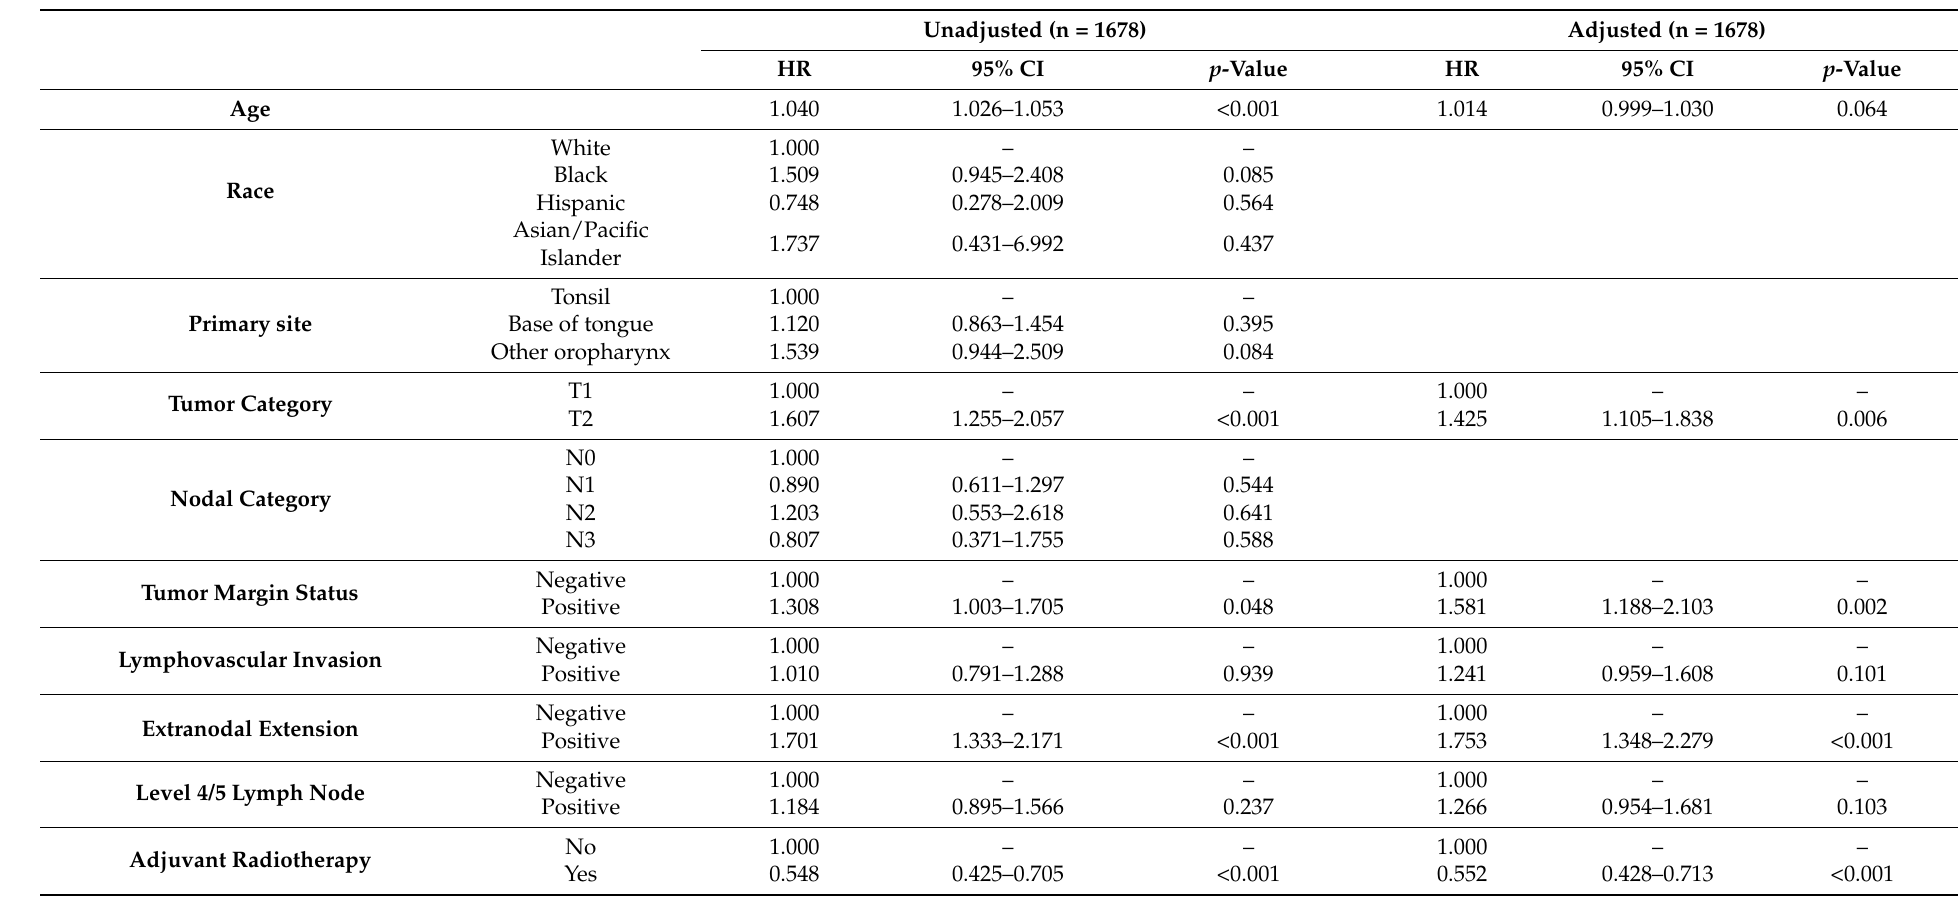
Table 3. Cox Proportional Hazards Analysis of the Propensity Score Matched